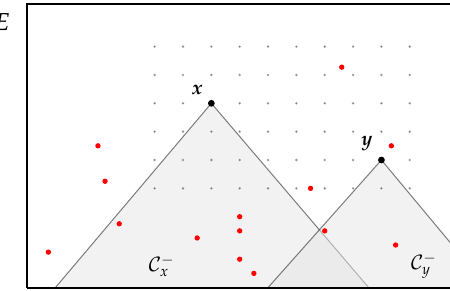
Figure 7. Two target events x and y with their input sets S x and S y